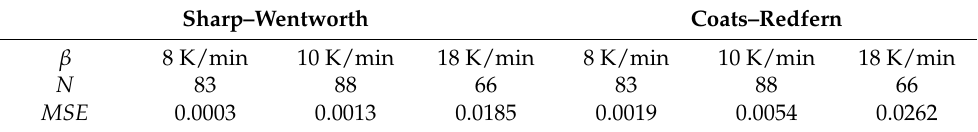
Table 6. The mean square errors of the reaction of Fe 3 O 4 → Fe for the explicit Euler